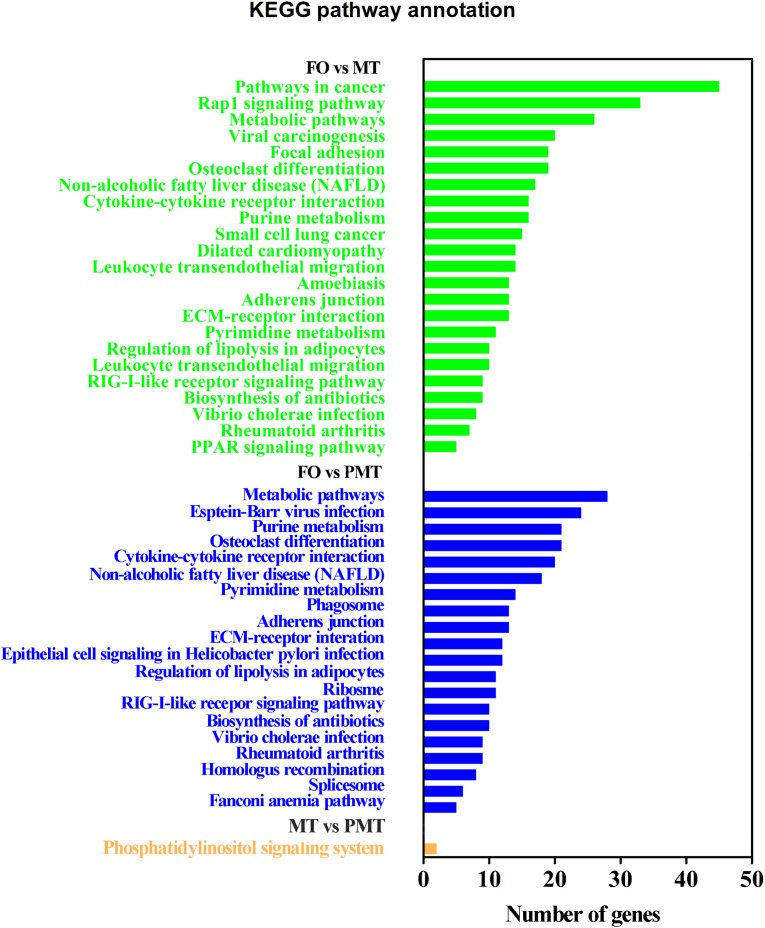
KEGG enrichment analysis of DEGs.